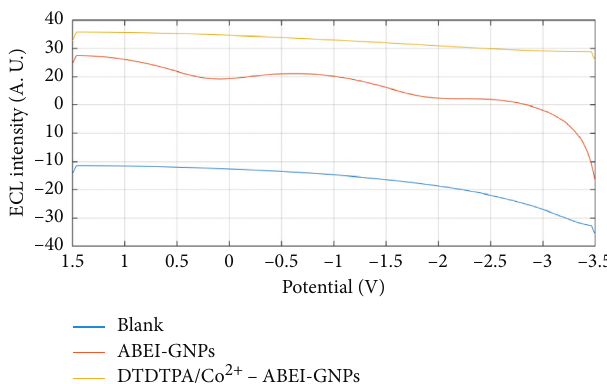
Figure 3: The I 2+ /DTDTPA/ABEI-GNPs obtained by cyclic voltammetry under air saturation. ECL -E curves of Co